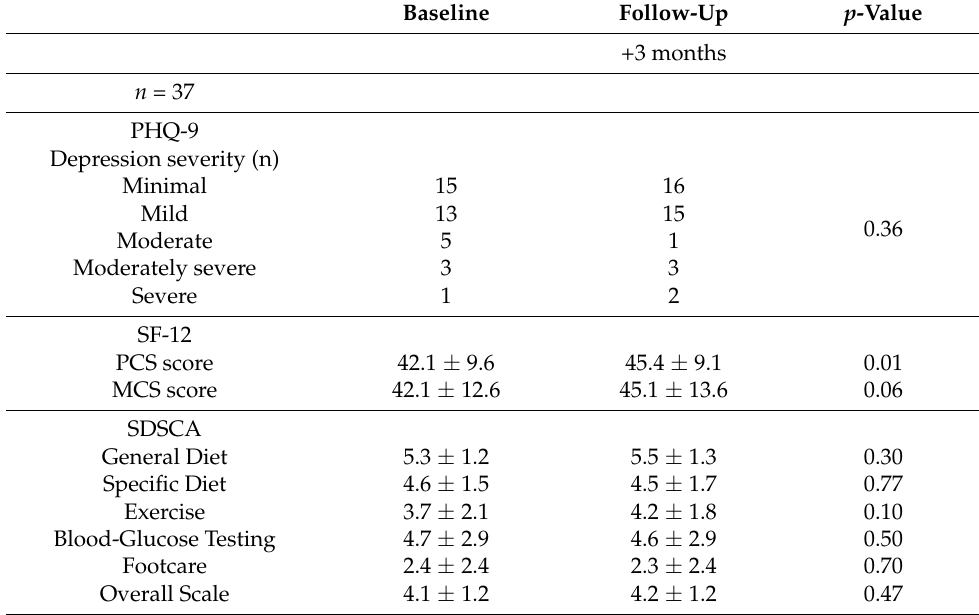
Table 3. Patient reported outcomes.